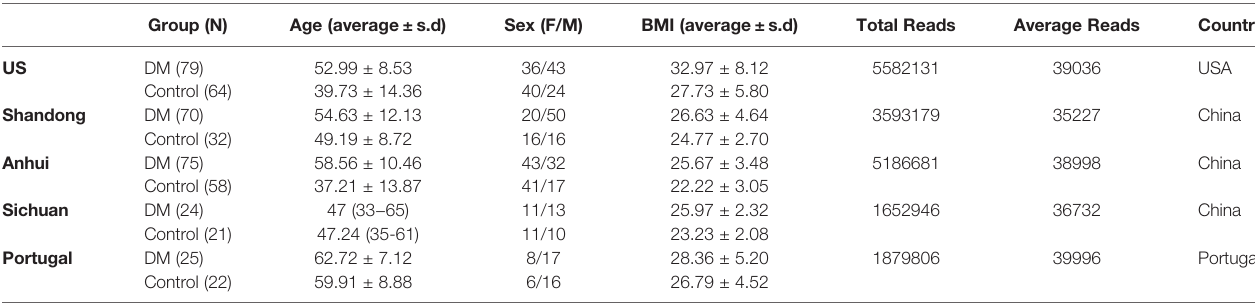
TABLE 1 | Clinical Characteristics of Large-Scale Dataset *